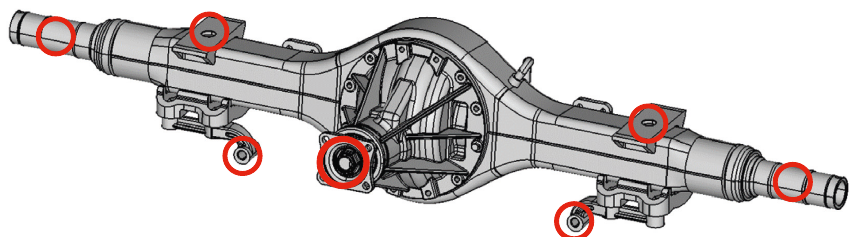
Figure 10: The positions where the rear axle is connected to the outside.